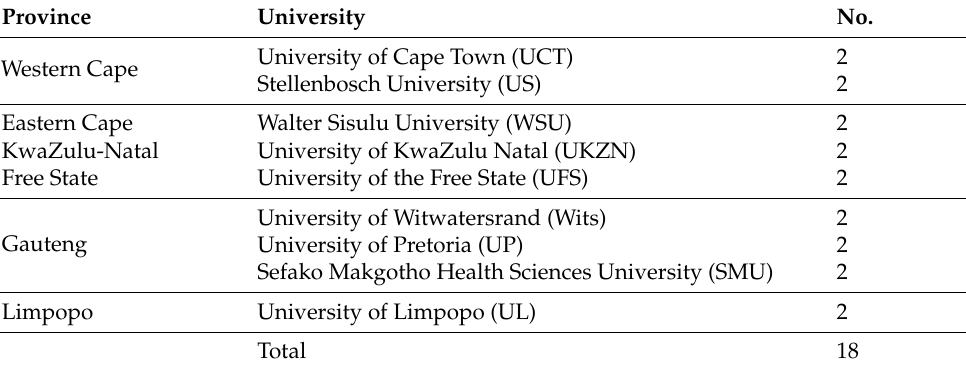
Table 1. Selection of experts from academic departments of family medicine (Source: Mash et al. [35]). Province